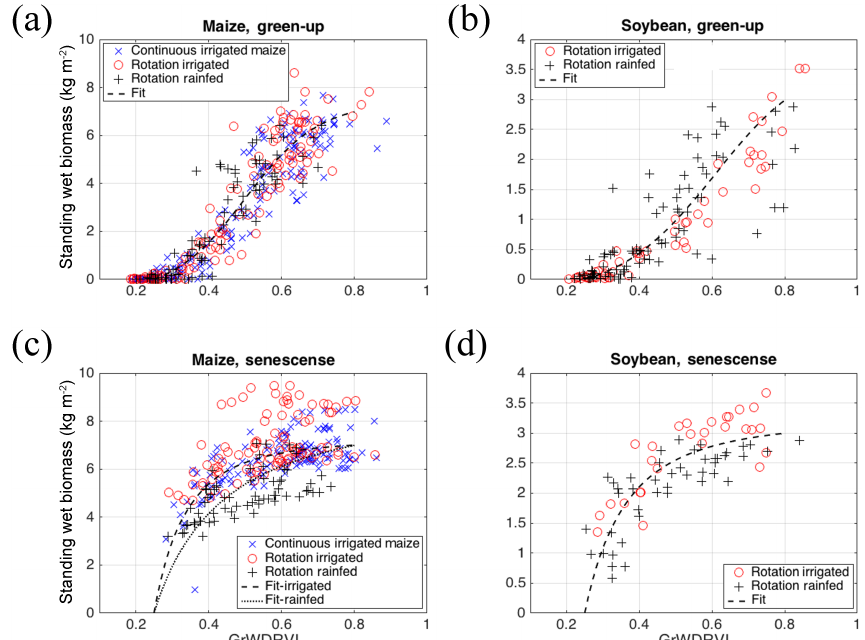
Figure 4. Relationship between GrWDRVI and observed standing weight biomass for maize (a, c) and soybean (b, d) partitioned into green- up (DOY < 210 for maize, DOY < 230 for soybean) and senescence. Destructive vegetation data are aggregated from three fields near Mead, NE, between 2003 and 2013 (Table S2). The regression coefficients and equations are summarized in Table S3. Note that the maize and soybean functions were subject to the constraints in order to provide realistic behavior at the observed GrWDRVI and destructive vegetation sampling bounds. See main text for details.